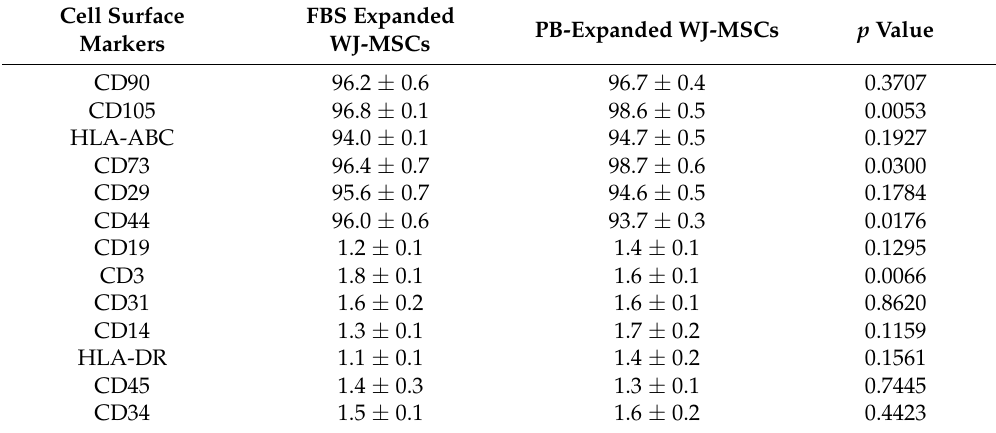
Table 4. Cell surface markers expression (%) at FBS and PB-PL expanded